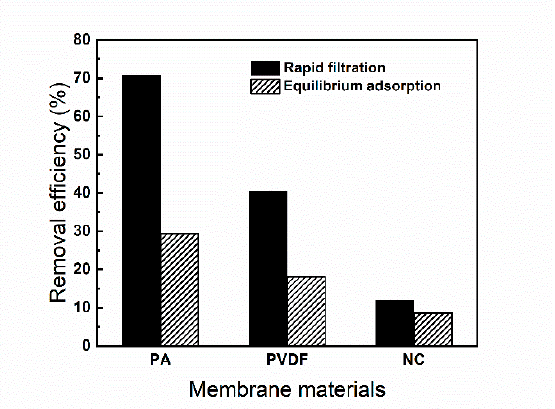
Figure 5. The removal efficiency of BPA on different MFMs by rapid filtration and equilibrium adsorption. (The removal efficiency of different MFMs immersed in 50 mL of 10 mg/L BPA solution for 24 h was compared with the removal efficiency of different MFMs filtering 50 mL of 10 mg/L BPA